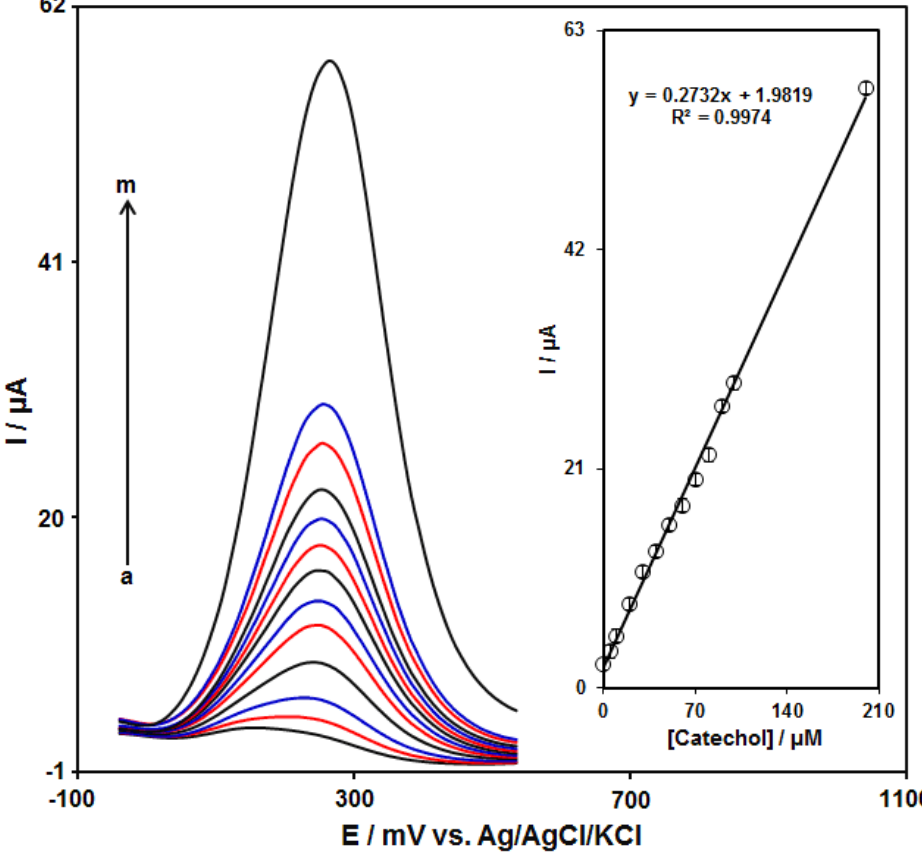
Figure 6. DPV responses of GO–PAMAM/ILCPE sensor toward catechol (a: 0.1, b: 5.0, c: 10.0, d: 20.0,